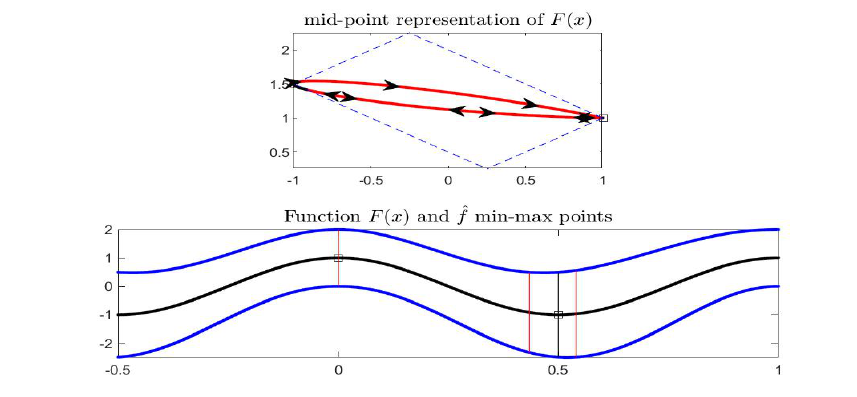
Figure 5. Local min and max points of F(x) in Example 2; function (cid:98) f ( x ) has a minimum point at 1 x m = and a maximum at x M = 0. Black colored intervals in midpoint representation ( top picture ) 2 5 1 ) for the local min and are not dominated by F ( x are not dominated by F ( x m ) = ( − 2; 2 for the local max. They correspond to the domain subintervals delimited by vertical red lines in the bottom picture